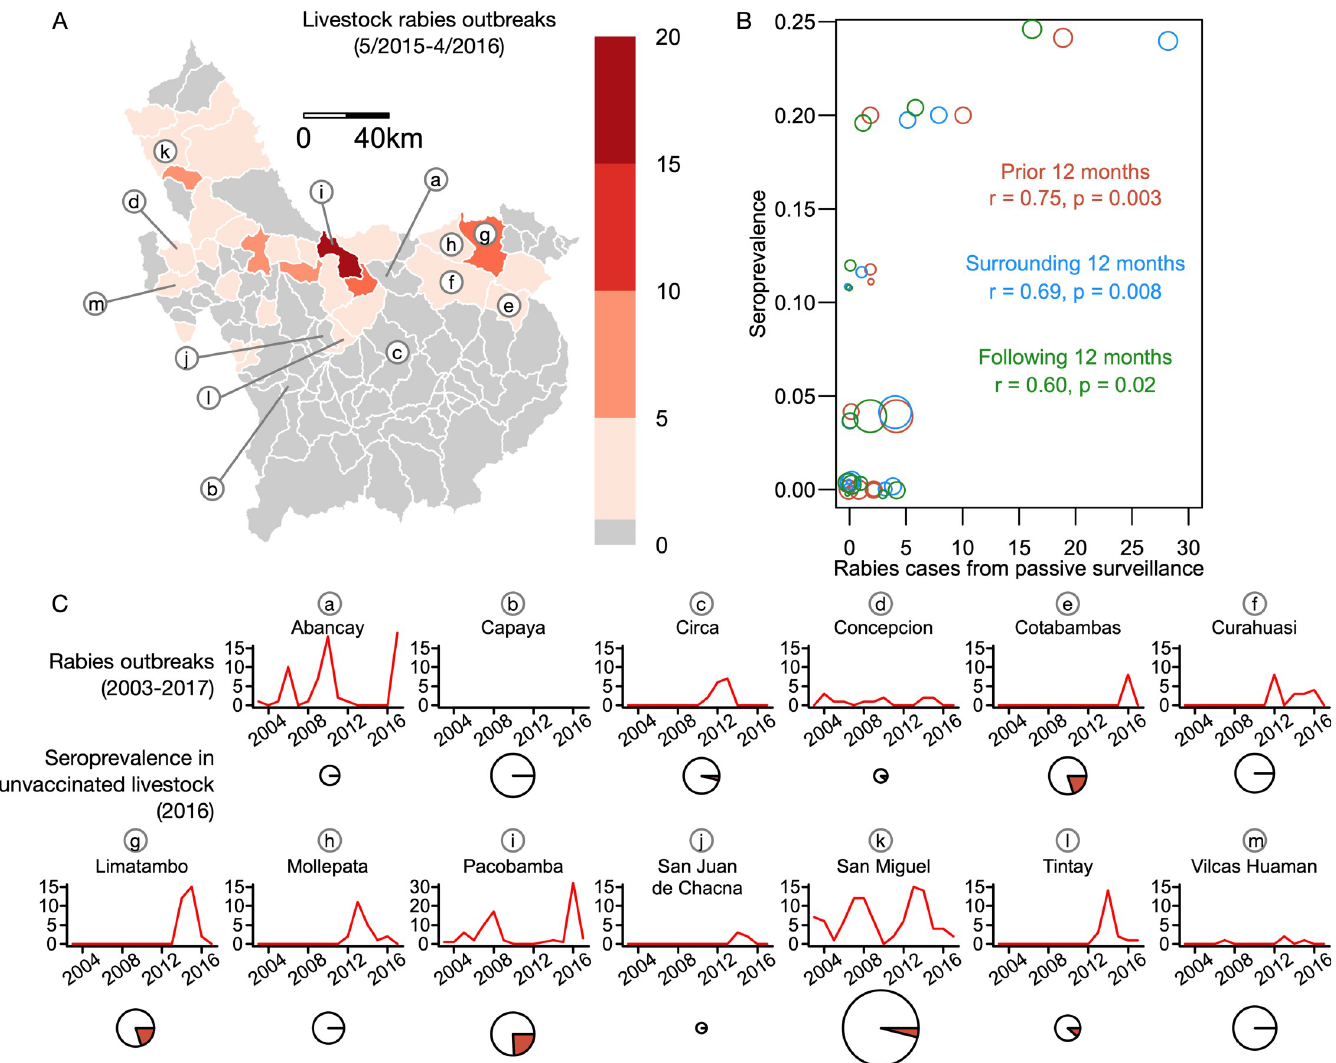
Fig 1. Spatiotemporal correlations between rabies mortality incidence and seroprevalence. (A) Map showing the districts of Peru where the study was carried out, color coded by the number of livestock rabies outbreaks reported to SENASA during 12 months prior to serological sampling. Lower-case letters correspond to districts shown in panel C. (B) Scatterplot showing the relationship between seroprevalence and rabies cases in the 12 months prior to sampling, in the 6 months surrounding sampling, and in the 12 months following sampling at each district. The size of points is scaled to sample size per district (range = 7–51 samples). The correlation coefficient (r) and its associated p-value of a Pearson’s correlation test are shown for each relationship. (C) Time series of rabies incidence in each sampled district from 2003–2017 showing sporadic outbreaks. Pie charts below indicate the proportion of livestock in each district that were seropositive in 2016 (red = positive, white =